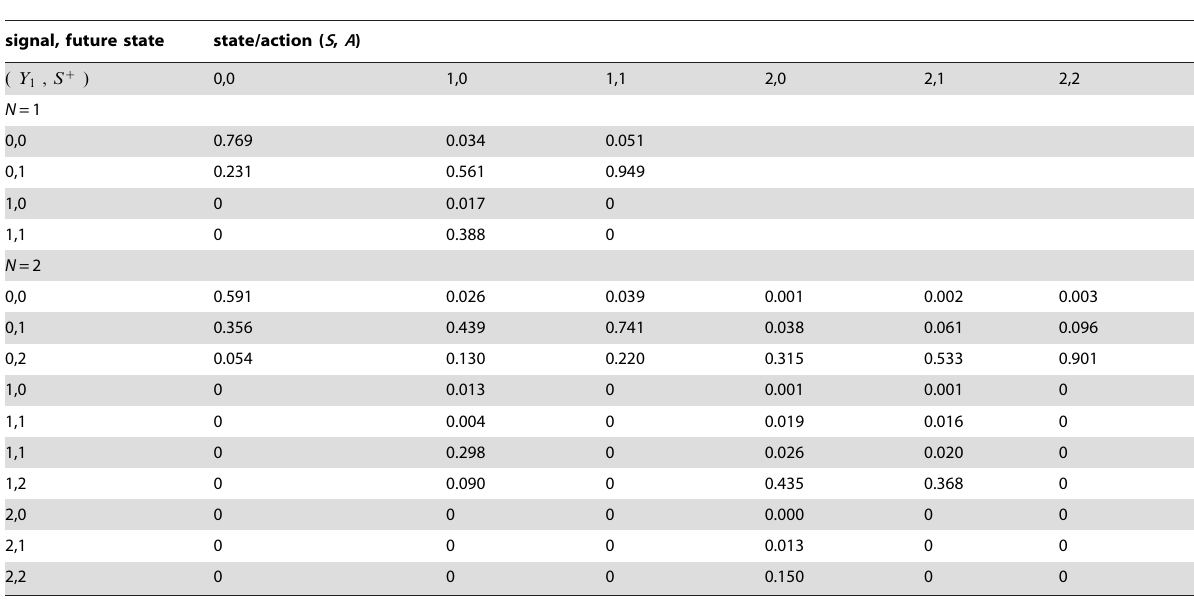
Table 5. Joint state/signal probability matrix for 1 and 2 sites.